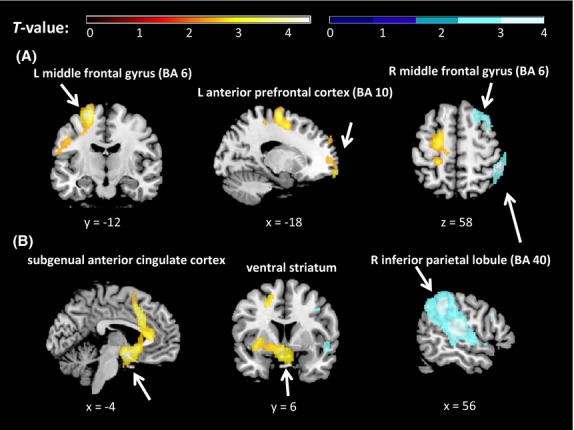
Whole-brain level ANOVA results showing regional cerebral blood flow (rCBF) levels for the contrasts (A) sad versus neutral and (B) happy versus neutral, overlaid on a T1-weighted structural brain image. Orange = increased rCBF relative to neutral, blue = decreased rCBF relative to neutral. All locations are reported in MNI coordinates. For illustration purposes, the cluster-level significance is P < 0.05 (AlphaSim corrected). BA, Brodmann area; L, left; R, right.